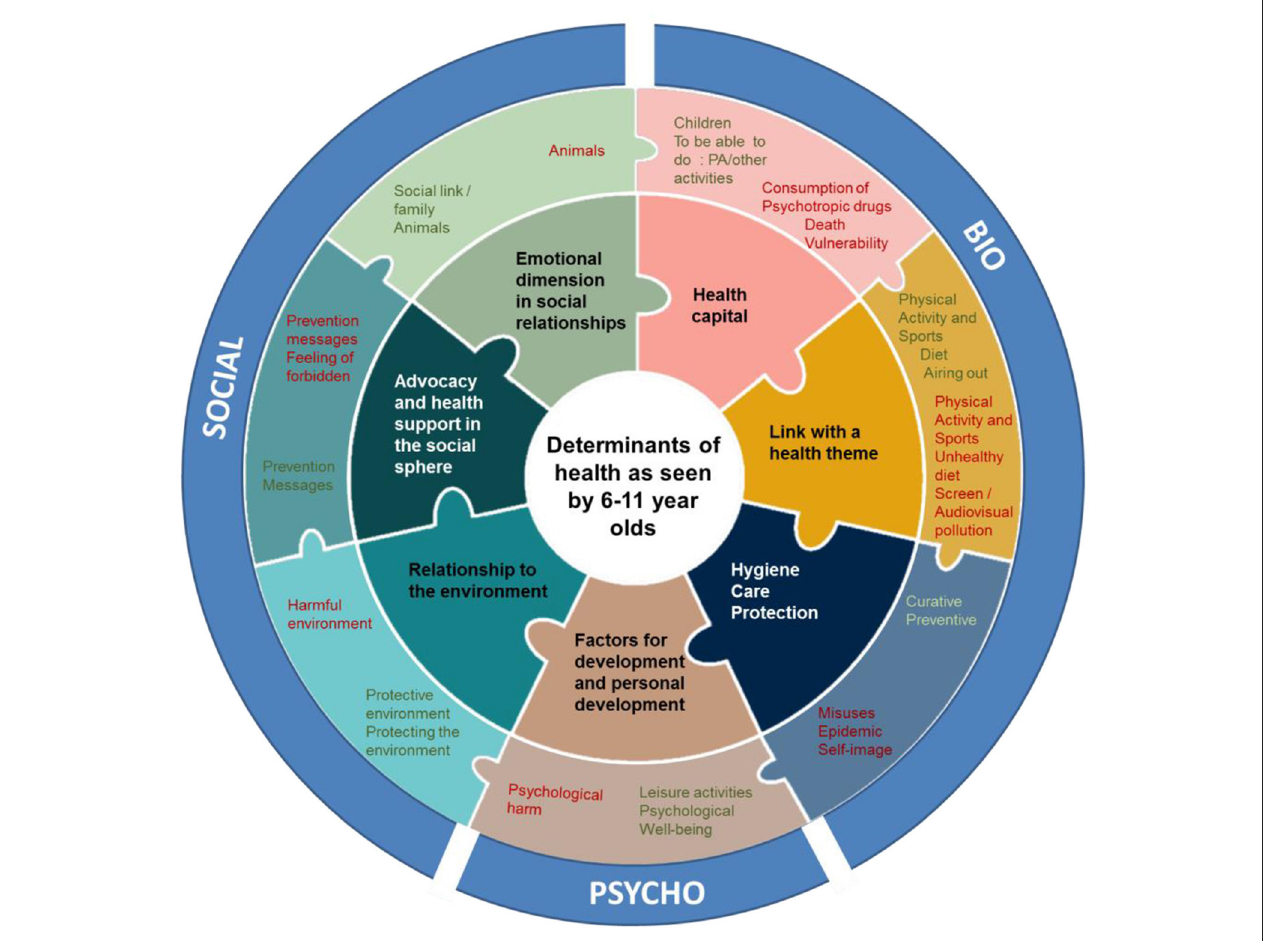
FIGURE 1 | Modeling of the determinants of health expressed and perceived by 381 children aged 6–11 (6). PA, Physical